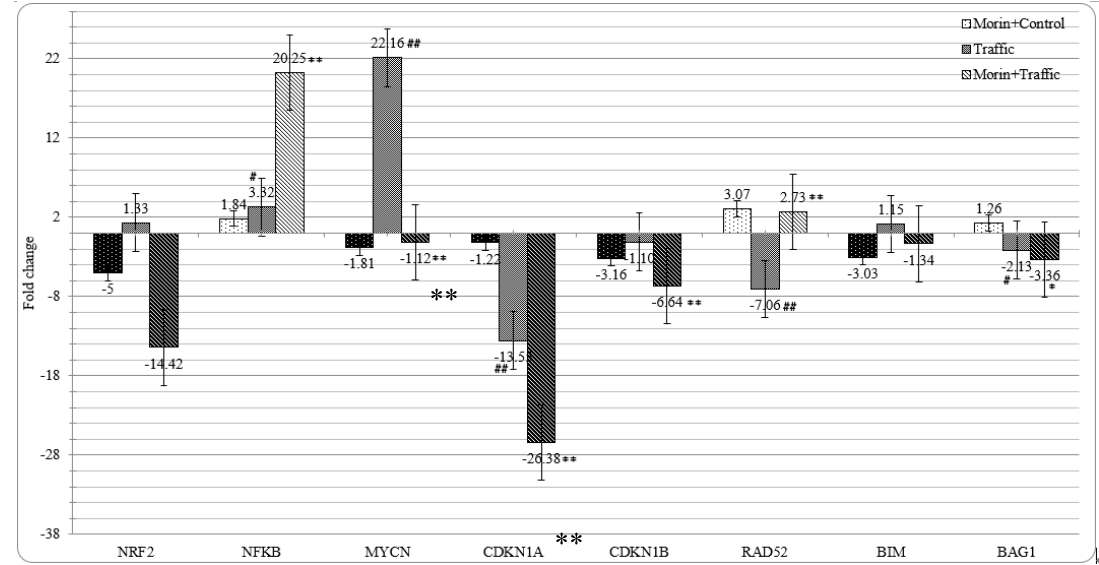
Figure 8. Morin and tra ffi c PM 2.5 on target gene expression in A549 cells, N = 3 ± SD. # p < 0.05, Figure 8. morin and traffic PM 2.5 on target gene expression in A549 cells, N = 3 ± SD. # p < 0.05, ## p < ## p < 0.01 compared to the untreated control cells, ** p < 0.01, compared to PM 2.5 -treated